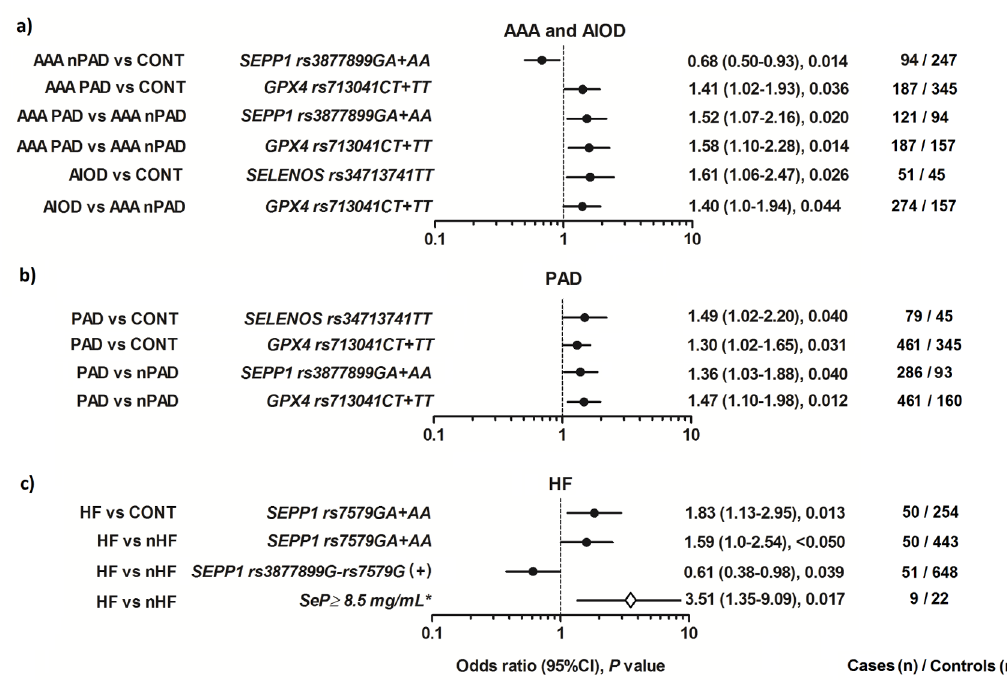
Fig 1. Significant associations between the studied SNPs and SeP levels, and (a) development of the studied aortic diseases: abdominal aortic aneurysm (AAA; N = 564) or aortoiliac occlusive disease (AIOD; N = 400), and (b) occurrence of systolic heart failure (HF; N = 81) and peripheral arterial disease (PAD; N = 664) in the studied patients. Effects in relation to the control group (CONT; N = 543) or corresponding reference group: without PAD (nPAD; N = 259) or without HF (nHF; N = 883) are shown. In evaluating the significance of SeP levels ( (cid:3) ), all individuals with a known concentration of SeP were included: 23 patients with HF and 142 subjects without